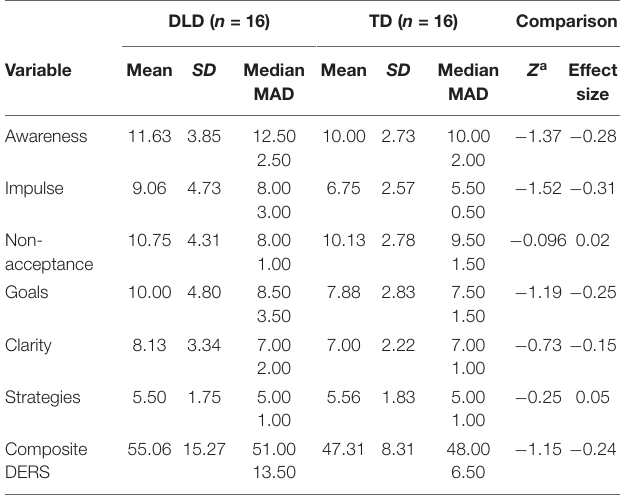
TABLE 7 | Emotion regulation for adolescent with Developmental Language Disorder (DLD) and typically developing (TD) adolescent measured at wave 2 (Study